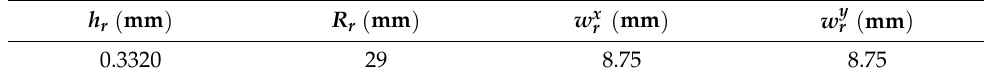
Table 5. Target surface parameters of the sample.